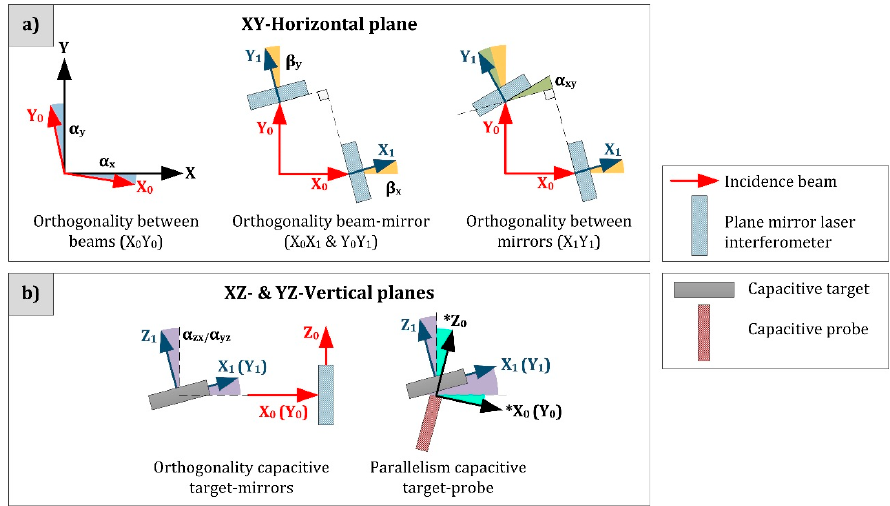
Figure 7. Existing misalignments in ( a ) XY-Horizontal Plane and ( b ) XZ- and YZ-Vertical planes, regarding the sensor scheme of plane mirror laser interferometers and capacitive sensors.